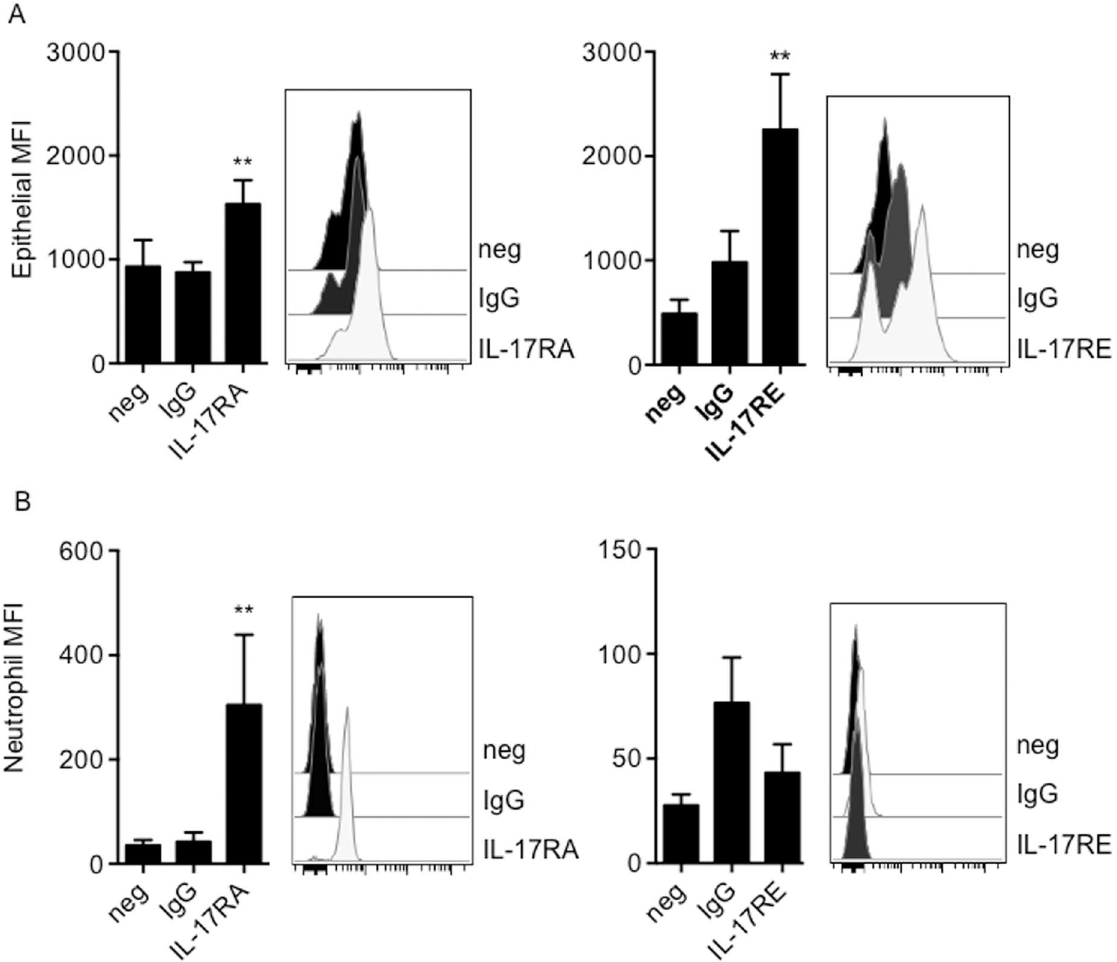
Fig 2. IL-17RA and IL-17RE expression on primary epithelial cells and neutrophils. IL-17RA and IL-17RE expressionwas assessed by flow cytometry in (A) primary AECs and (B) neutrophils. The results are depicted as mean ± SD of median fluorescence intensity (MFI) of a total of six (epithelialcells) or five (neutrophils) experiments. In addition, representative histograms are shown for each experiment. Abbreviations: secondary antibody control (neg), IgG control (IgG) or receptor expression on cells (IL-17RA/RE). Comparisons were performed with Mann-Whitney test and significance was accepted at * p < 0.05, ** p < 0.01, or *** p < 0.001.